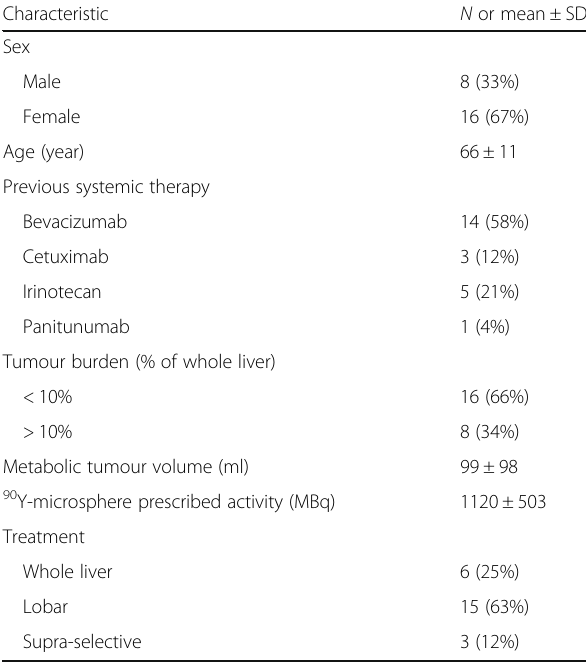
Table 1 Baseline characteristics of patients